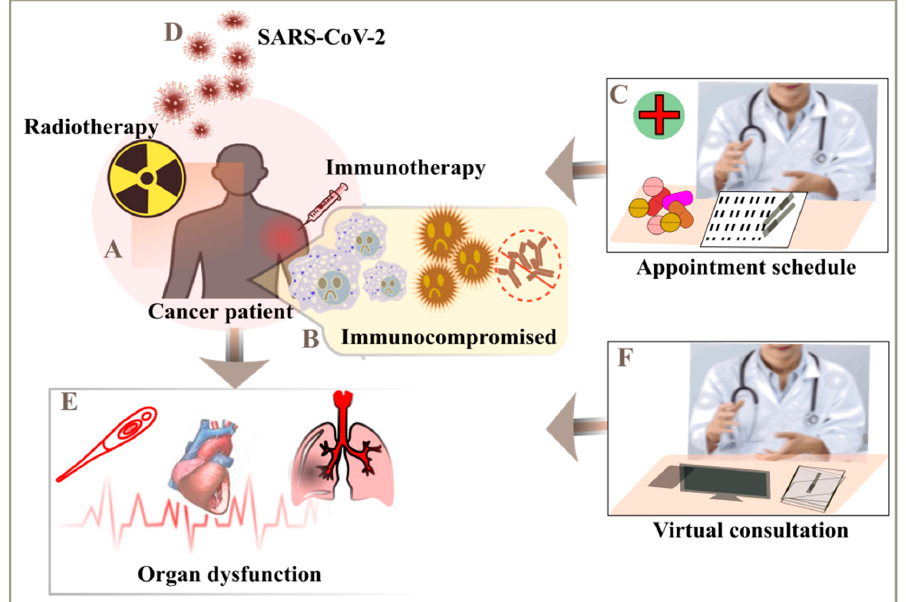
Figure 5. Monitoring of cancer patients to mitigate the severity risk. ( A ) Immunotherapy or radiotherapy considered for the treatment of cancer patients, ( B ) they usually have weak immune response, ( C ) follow-ups after the therapy, ( D ) cancer patients are more susceptible to SARS-CoV-2, ( E ) multiple complications includes septic shock, acute myocardial infarction (AMI) and acute respiratory distress syndrome (ARDS), ( F ) avoid visits to hospitals and opt for